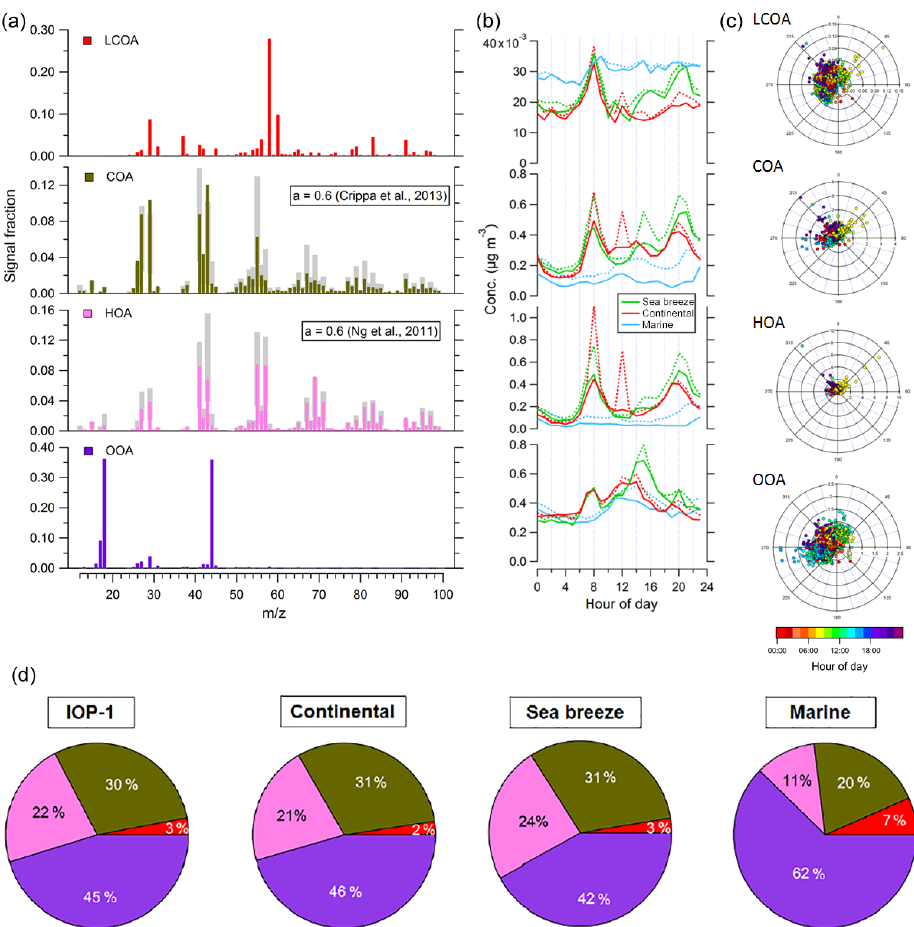
Figure 9. PMF constrained four-factor solution: (a) factor profiles of LCOA, COA, HOA (the two latter constrained) and OOA; (b) corre- sponding daily cycles according to day types (solid lines: median; dotted lines: average); and (c) pollution rose plots colored by time of day. (d) Average pie charts of the contributions to the total organic fraction for IOP-1, continental, sea breeze and marine